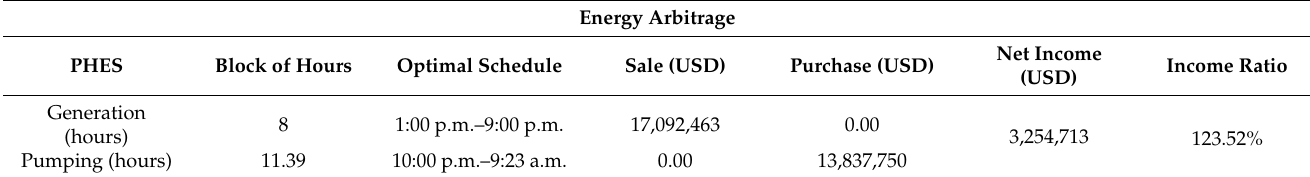
Table 13. Results to the service by energy